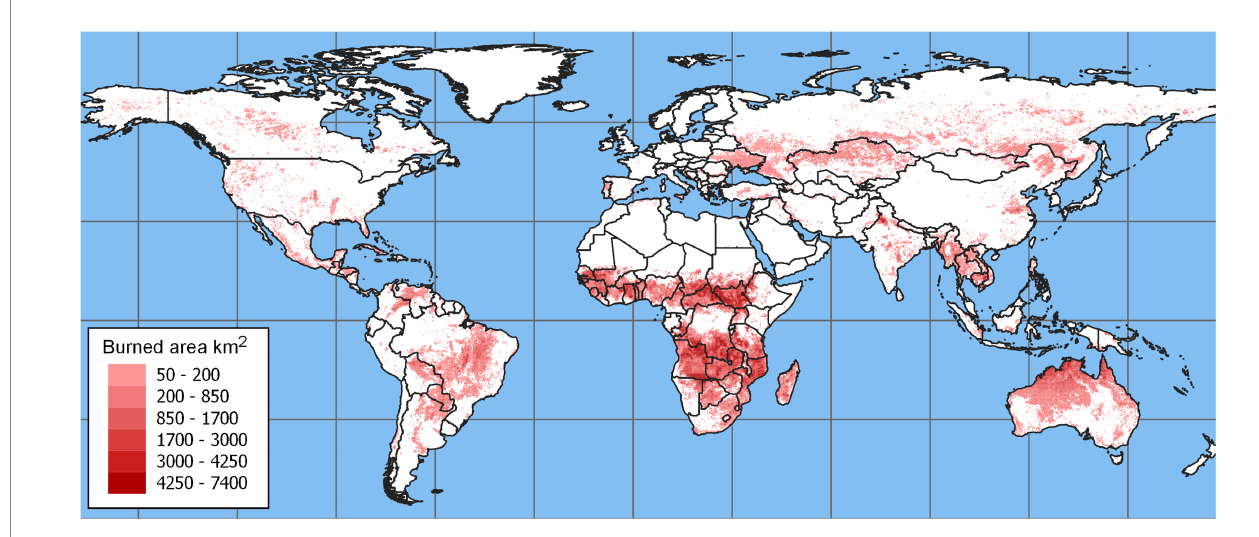
FIGURE 1 Satellite-derived data showing the annual total area burned in the world based on a time-series of rasters from 2008 to 2021. These data indicate that large fires are conspicuously concentrated in regions where tropical savannas occur, including Central Africa, Northern Australia, and the Cerrado of Brazil. The burned area is for all fire types and represents the total area (hectares) in each 0.25 degree x 0.25 degree grid cell. This figure was generated with MODIS/ MCD64A1 data (Giglio et al.